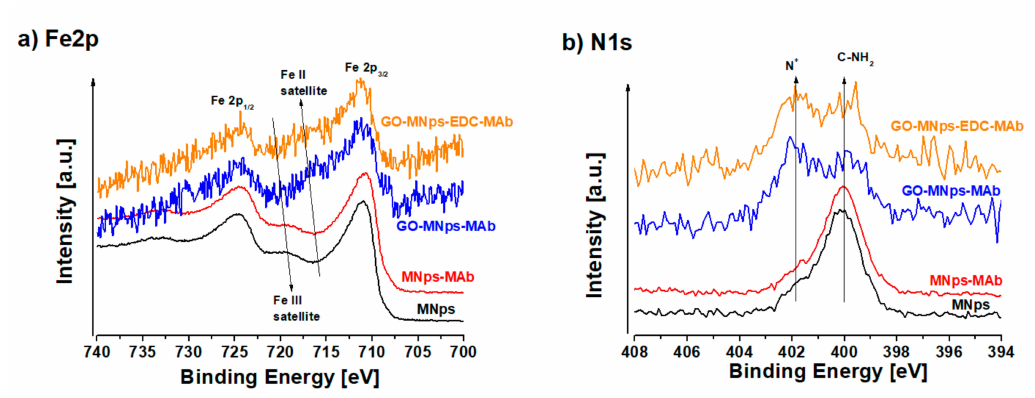
Figure 2. X-ray photoelectron spectroscopy of ( a ) Fe2p region and ( b ) of N1s region of magnetic nanoparticles (MNps), magnetic nanoparticles modified antibodies (MNps-MAb), graphene oxide platforms with magnetic nanoparticles modified antibodies (GO-MNps-MAb) and graphene oxide platforms with magnetic nanoparticles modified antibodies in the presence of